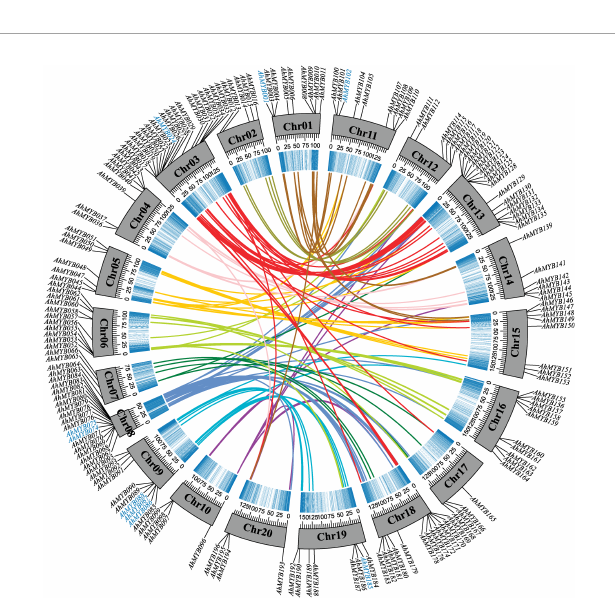
FIGURE 4 Circos diagram depicting the relationships of the chromosomes of A. hypogaea. Different colored connecting wires were used for different chromosome pairs. The blue color represented the density of genes. The scale for the gray bars was in megabases. Tandem duplication genes were highlighted in